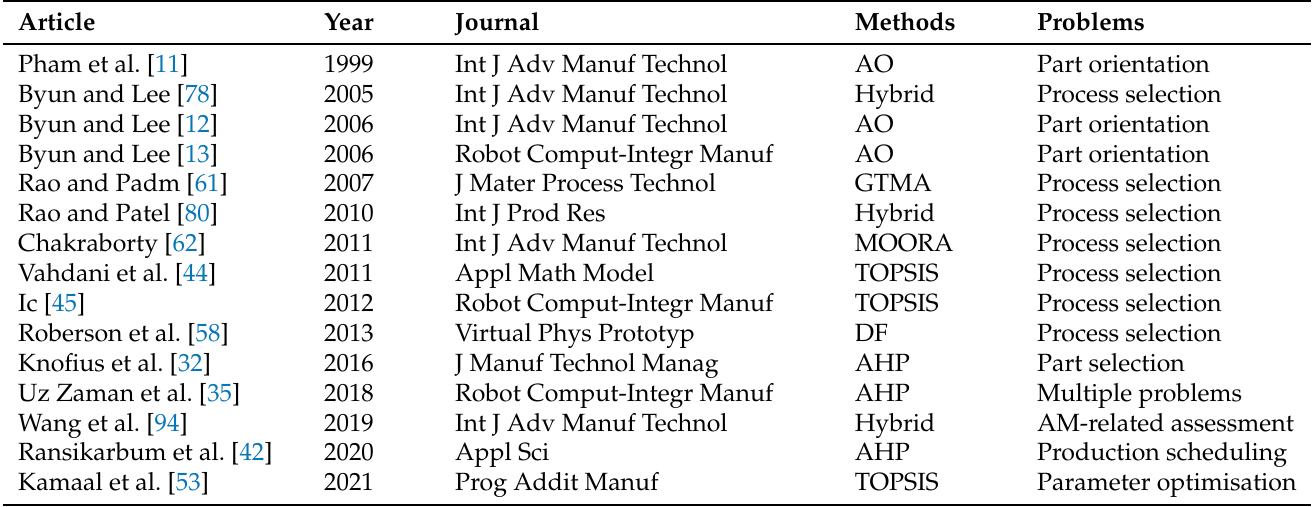
Table 1. Summary of the fifteen highly cited articles about MADM methods in AM.